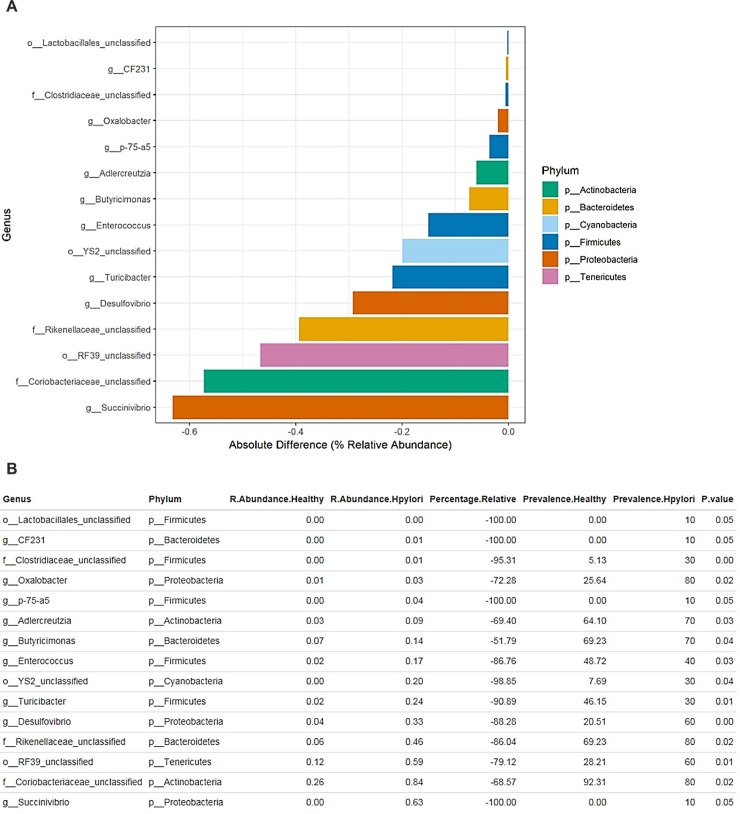
Exploration of the bacterial diversity in H. pylori infected and healthy subjects.(A)The bar plot reports only genera with an absolute percentage difference between H. pylori infected and healthy averages >0.1% and a p-value < 0.05, evaluated by means of ANOVA statistical analysis. (B) The table indicates the bacterial genera, the relative abundance and the prevalence of each group, the relative percentage difference and the p-value.